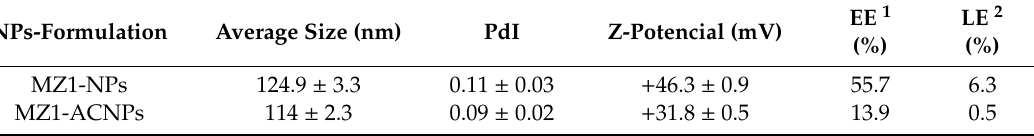
Scheme 1. Synthetic methodology for NPs design. Table 1. Average size, polydispersity index (PdI), and Z-potential of the di ff erent formulation obtained Table 1. Average size, polydispersity index (PdI), and Z-potential of the different formulation by dynamic light scattering (DLS). obtained by dynamic light scattering (DLS).